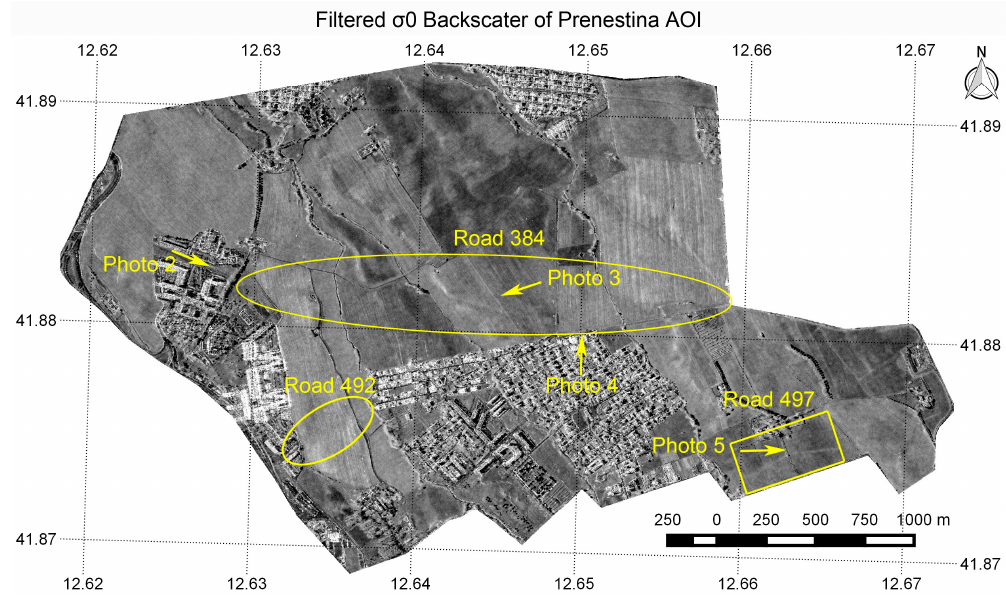
Figure 28. Image of filtered σ 0 backscatter over the Prenestina AOI acquired on 25 July 2010. Annotations in yellow show the locations of residues and the locations and directions from which photographs were acquired on the ground. COSMO SkyMed data provided by the Italian Space Agency.